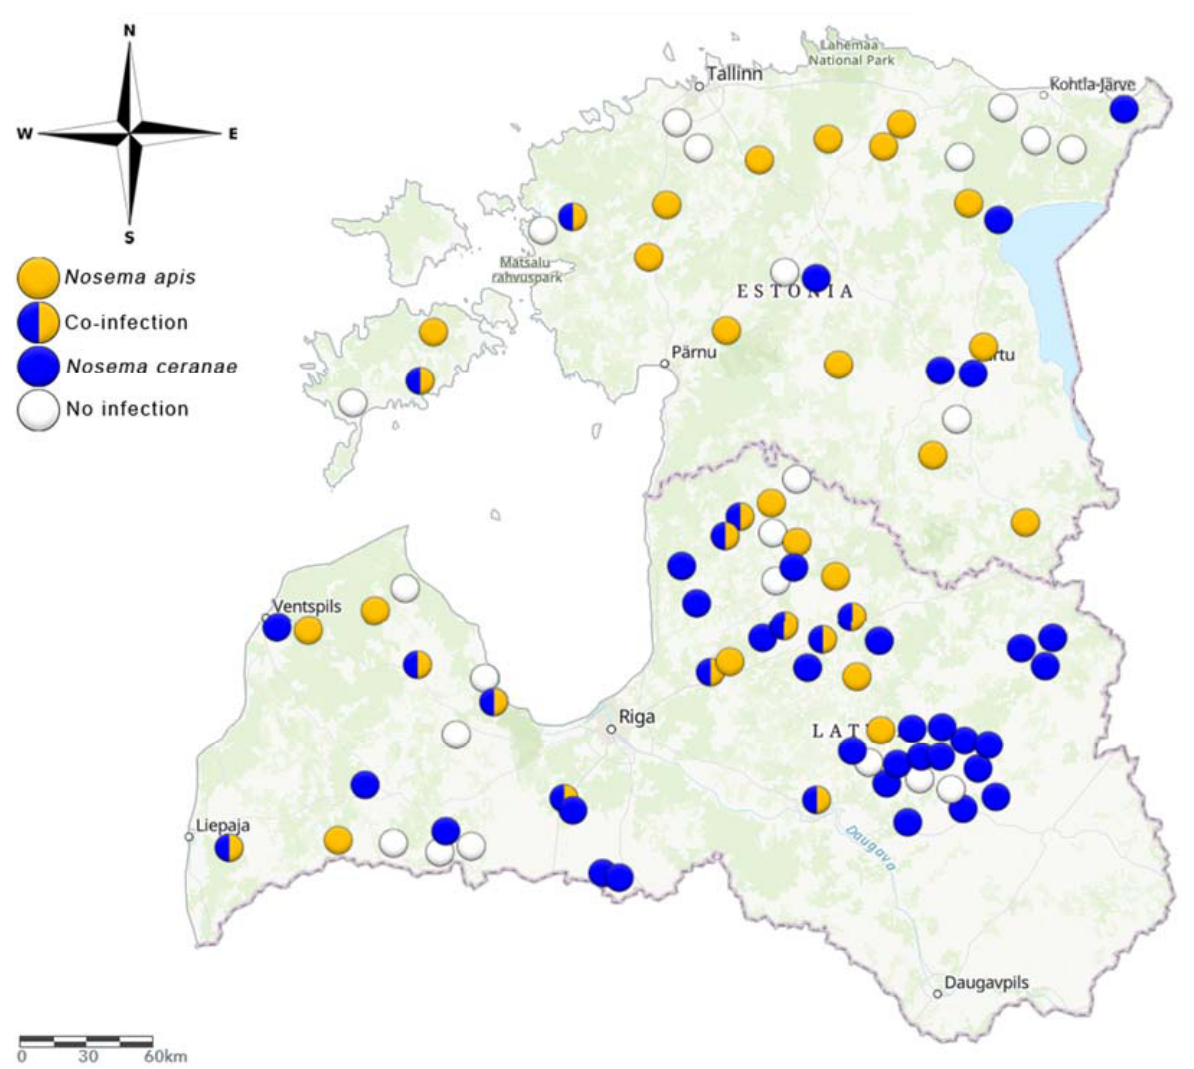
Figure 1. Prevalence of nosemosis causative agents ( Nosema ceranae and Nosema apis ) in Estonia in 2017 (May) and Latvia in 2018 (May) (ArcGis online).